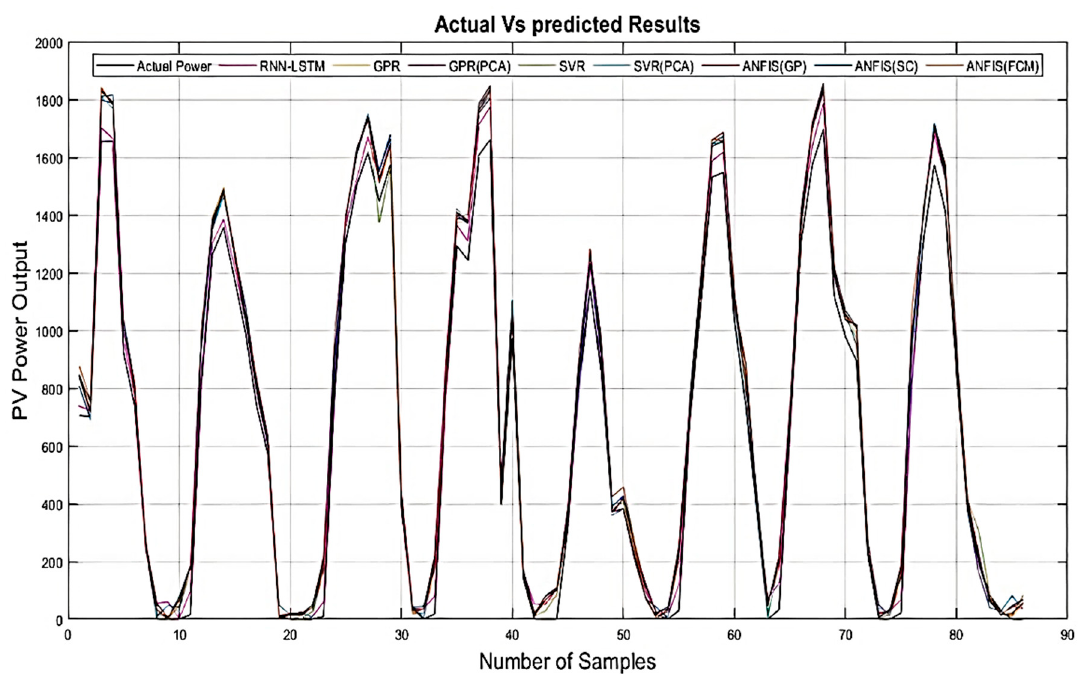
Figure 15. Prediction results of different prediction methods for the a-si PV